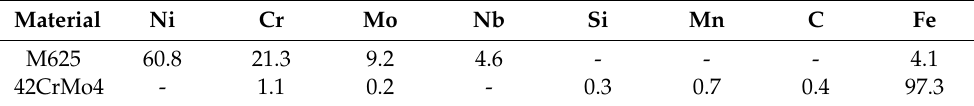
Table 1. Chemical composition of M625 powder and 42CrMo4 steel (wt.%).